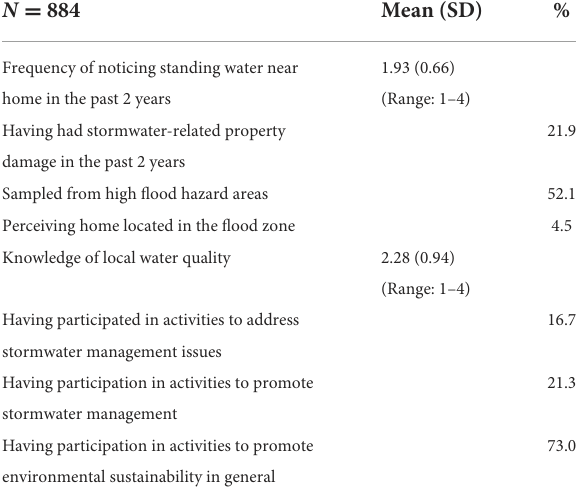
TABLE 3 Respondents’ experience of localized flooding and other contextual